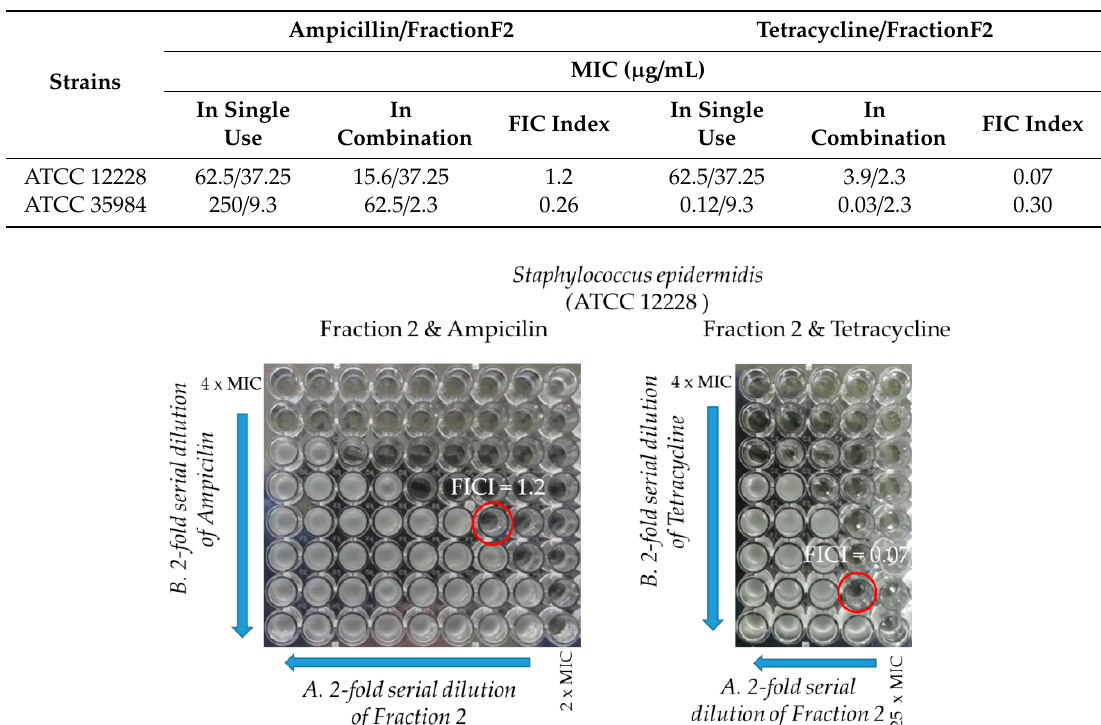
Figure 7. Effect of the combination of fraction F2 with antibiotics: ampicillin (left) and tetracycline (right) against certified S. epidermidis ATCC 35984. FICI arrows indicate the direction of the decreasing concentration. Fraction F2 MIC = 9.3 μ g/mL. 2.3.3. Anti-Biofilm Activity The effects of fraction F2 on the inhibition of biofilm formation were investigated. The biofilm of certified and clinical S. epidermidis strains was grown in the presence of a decreasing concentration of fraction F2. The results revealed that the amount of biofilm formed by various strains of S. epidermidis was differently affected upon the exposure of fraction F2 (Figure 8).